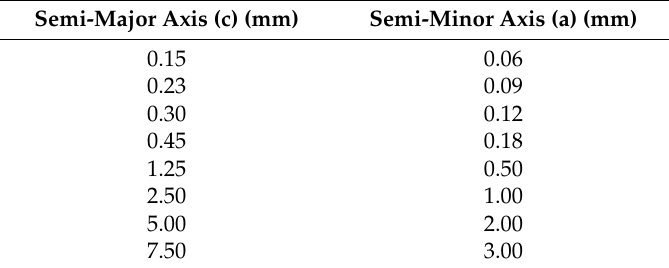
Table 4. Crack sizes of semielliptical section.